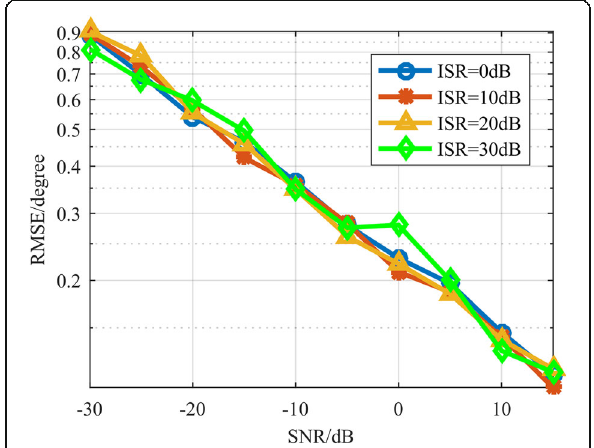
Fig. 5 RMSE versus SNR, N = 100